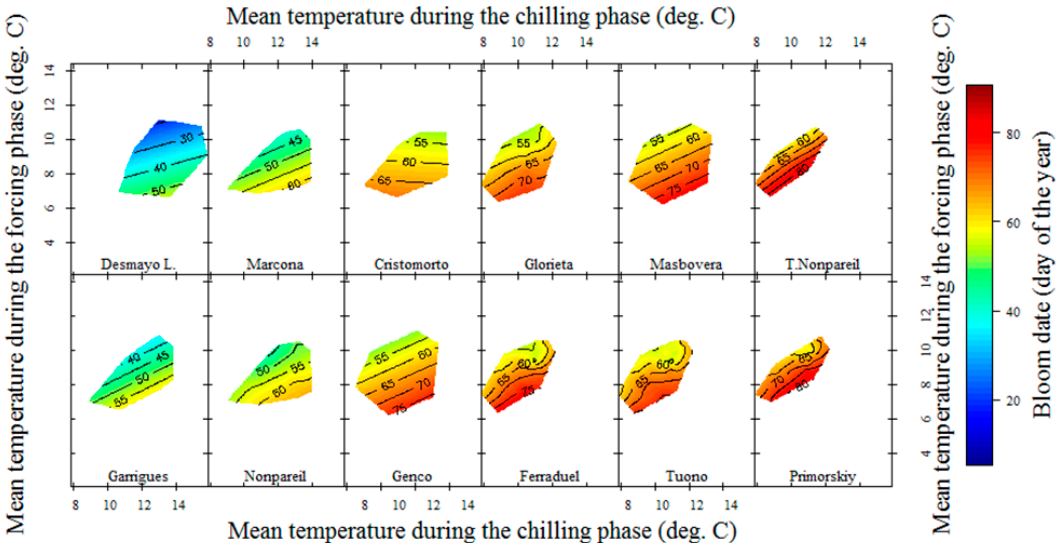
Figure 7. Response of ‘Desmayo Largueta’, ‘Marcona’, ‘Cristomorto’, ‘Glorieta’, ‘Masbovera’, ‘Tardy Nonpareil’, ‘Garrigues’, ‘Nonpareil’, ‘Genco’, ‘Ferraduel’, ‘Tuono’, and ‘Primorskiy’ blooming dates to mean temperatures during the chilling and forcing phases in Mas de Bover for the period 1979–2015. Isolines connect homogeneous blooming dates in this space. The color spectrum has to be interpreted as variation of the flowering dates. Individual plots can be found in Supplementary Figures S35 to S59.